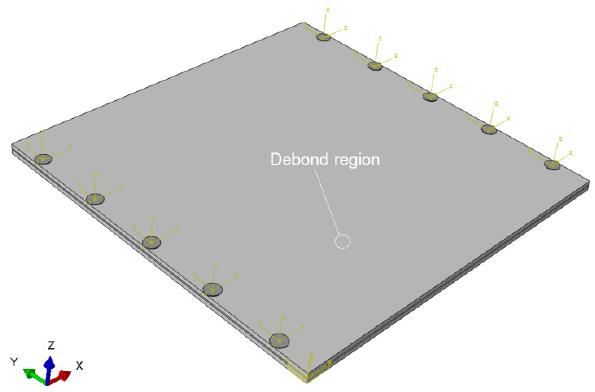
Figure 5. A numerical model of the ACCS sample for the simulation of guided wave propagation.